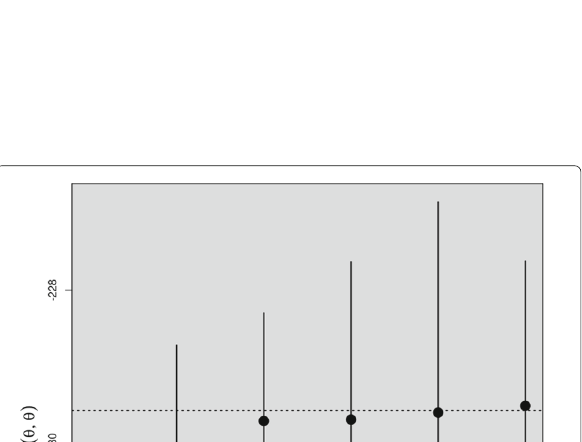
Fig. 3 Log-growth model - EM intermediate quantity. Estimation of the EM intermediate quantity Q (θ , θ) using the fixed lag (FL) technique for five different lags, and the GRand PaRIS algorithm using 200 replicates. The whiskers represent the extent of the 95% central values. The dot represents the empirical mean over the 200 replicates. The dotted line shows the reference value, computed using